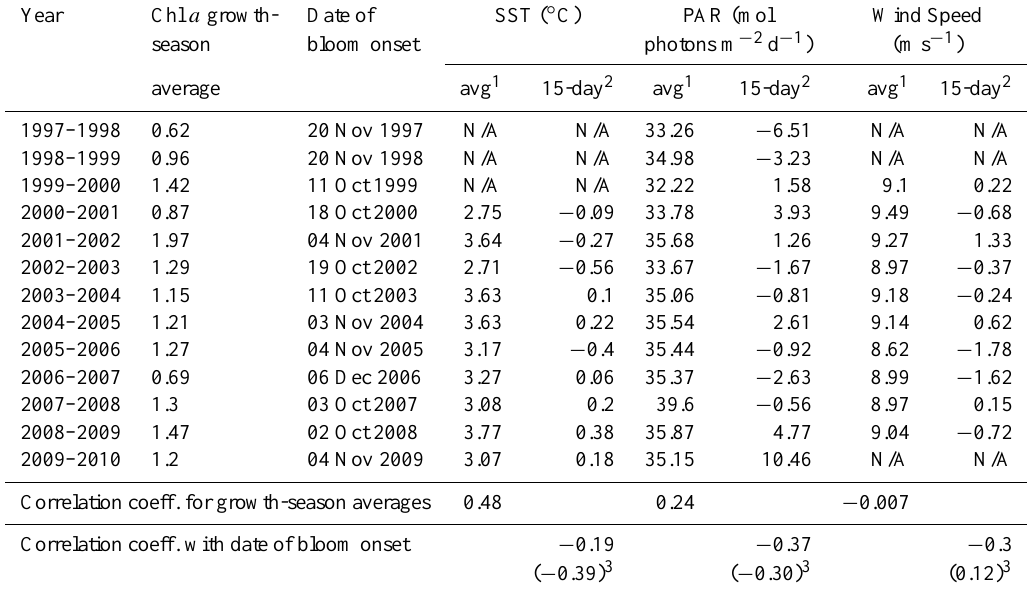
Table 2. SST, PAR and wind speed growth-season averages (from 27 October to 02 April) and 15-day anomalies prior to each year’s date of bloom onset. Coefficients obtained from their correlations with the Chl a growth-season average (in Column 2) and the date of bloom onset (in Column 3) are also reported.